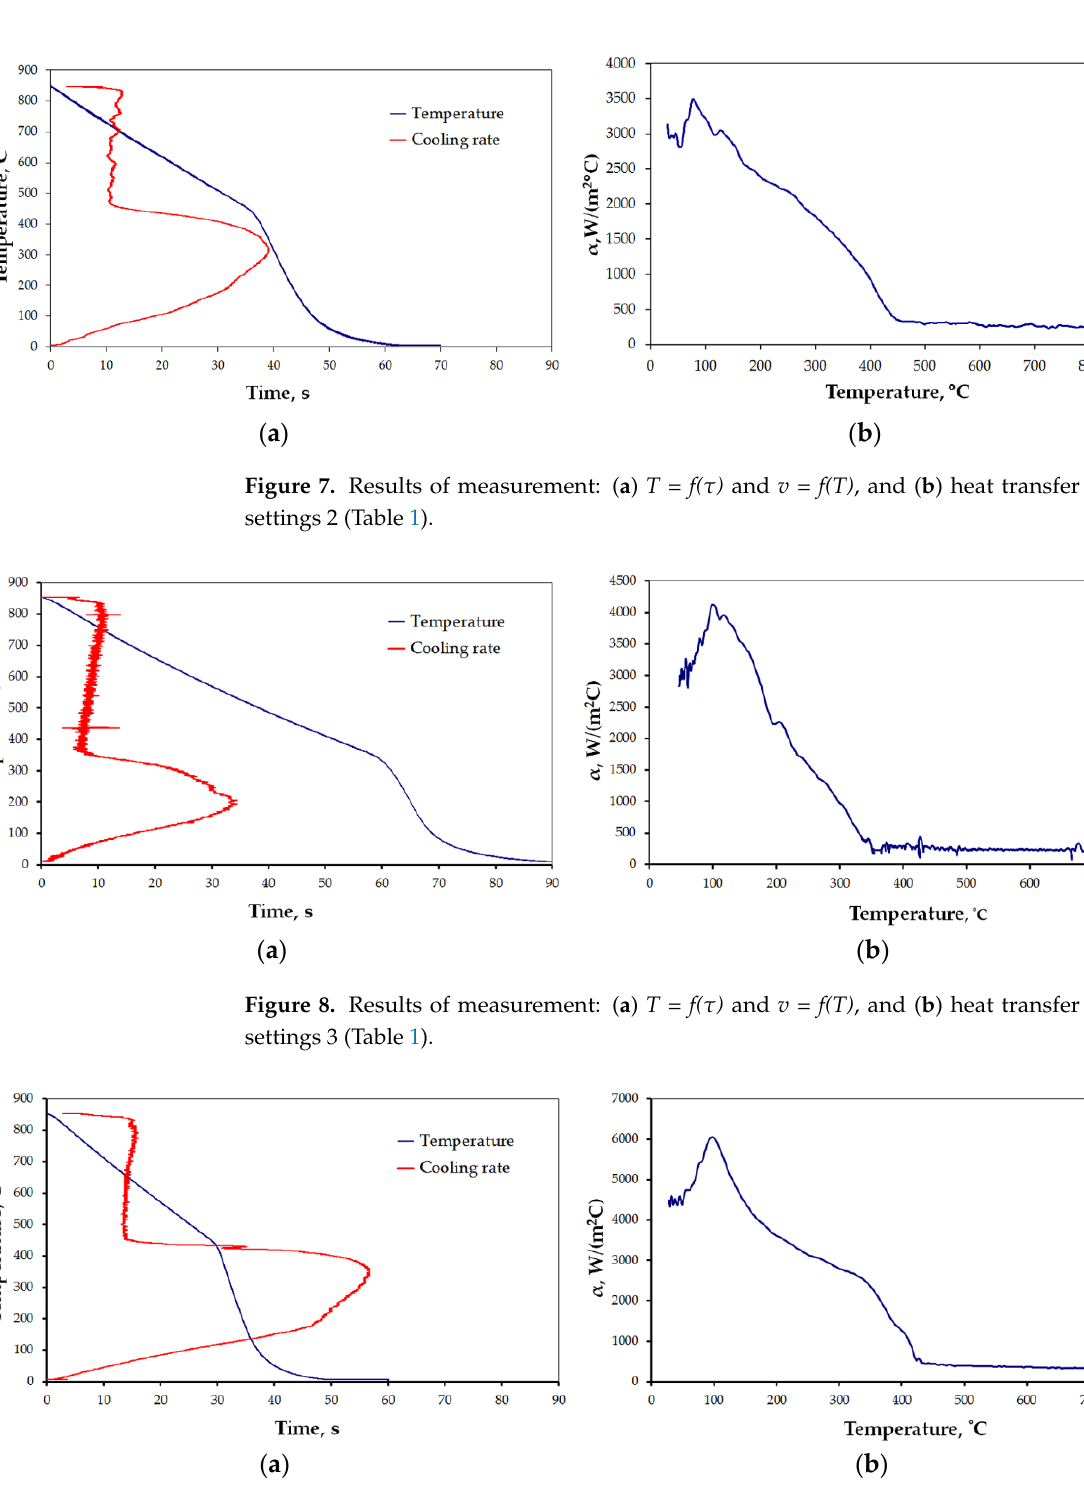
Figure 6. Results of measurement: ( a ) T = f( τ ) and v = f(T) , and ( b ) heat transfer coefficient for settings 1 (Table 1).